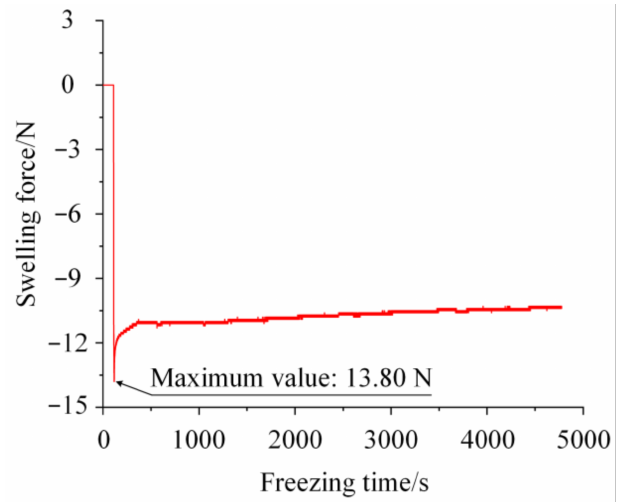
Figure 3. Swelling